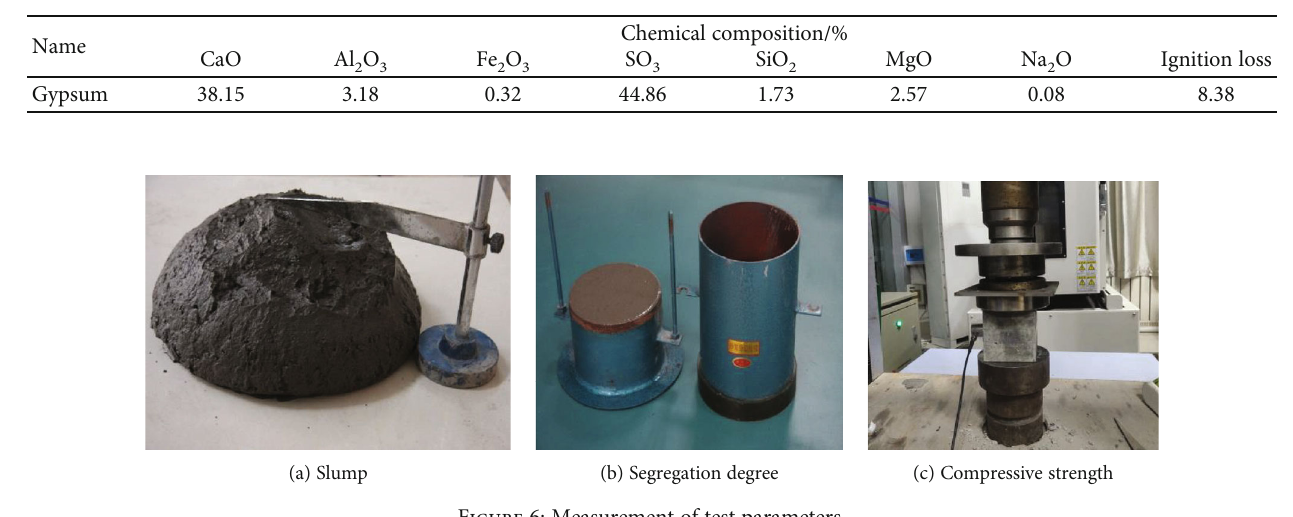
Table 2: The chemical composition of the gypsum.